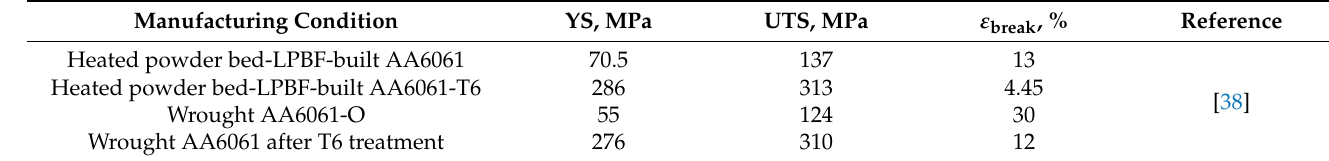
Figure 9. Microstructure of AA6061 fabricated with preheated laser powder-bed at 500 ◦ C: ( a ) XY plane; ( b ) ZX plane (build direction). Reproduced with permission from Elsevier [38]. Table 5. Mechanical properties of the LPBF-built and cast AA6061 after annealing and T6 aging heat treatment. YS is yield strength, UTS is ultimate tensile strength, and ε break is the elongation at fracture.